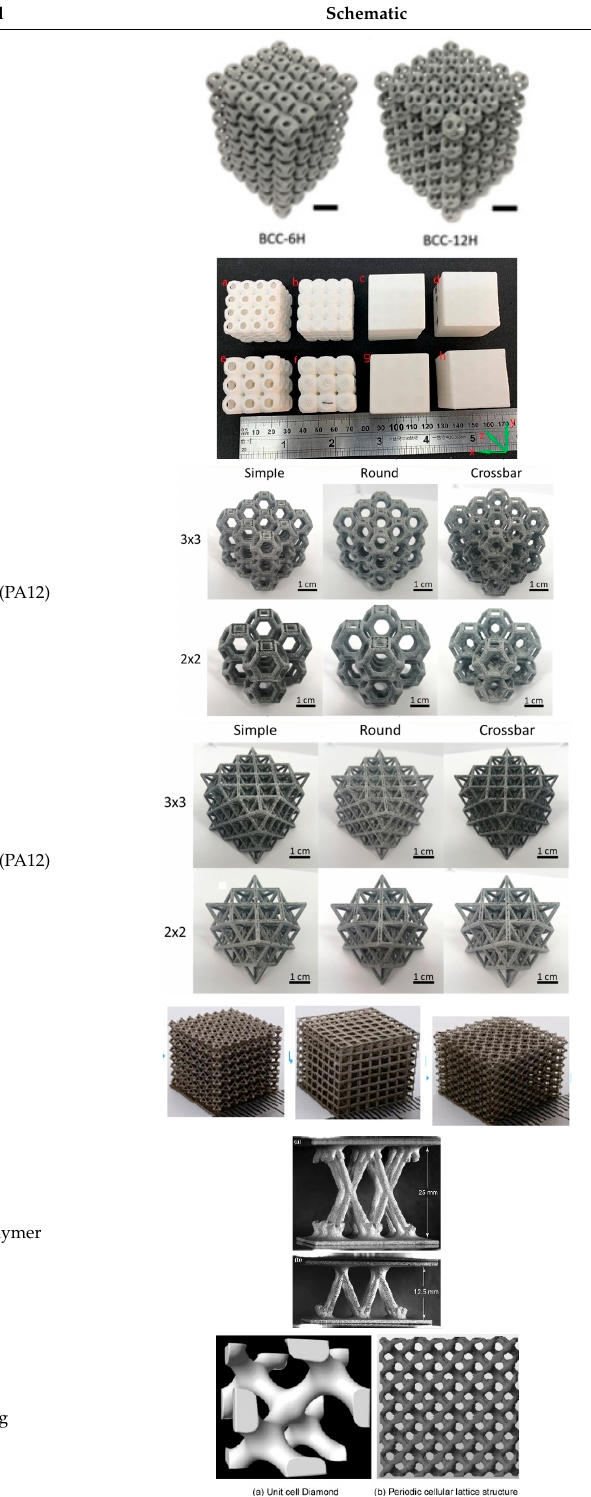
Diamond unit cell and periodic cellular lattice